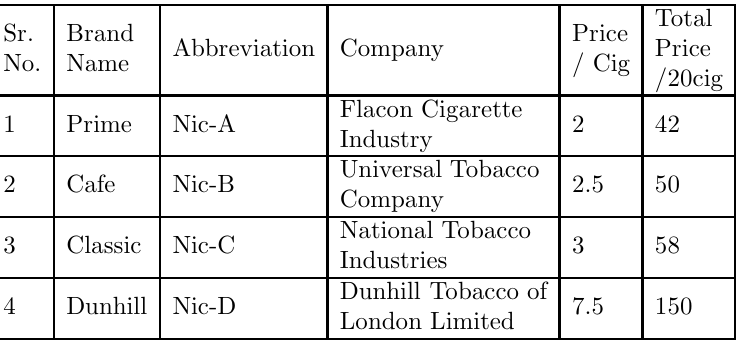
Table 1. Label information of five different brands of cigarette Sr.